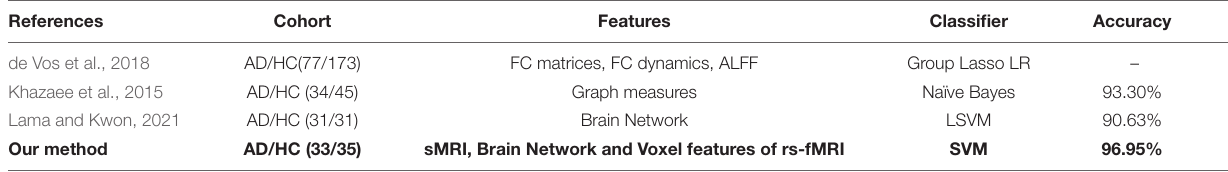
TABLE 6 | Performance comparison of AD vs. HC with state-of-the-art methods.